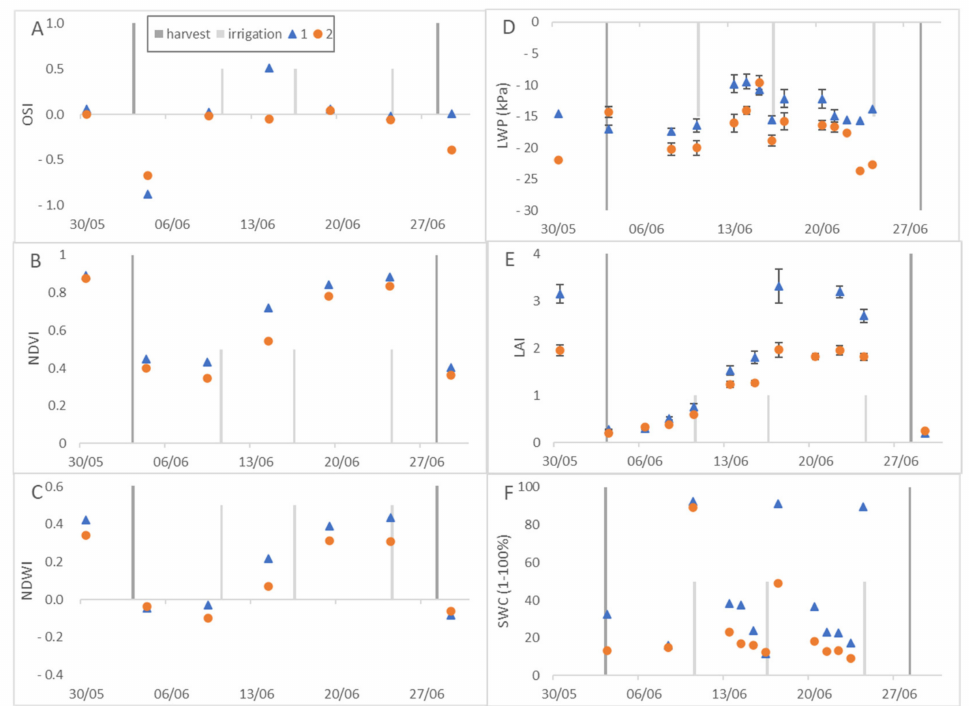
Figure 7. The spectral data ( A – C ) and crop measurements ( D – F ), sites 1 and 2, the fourth growth